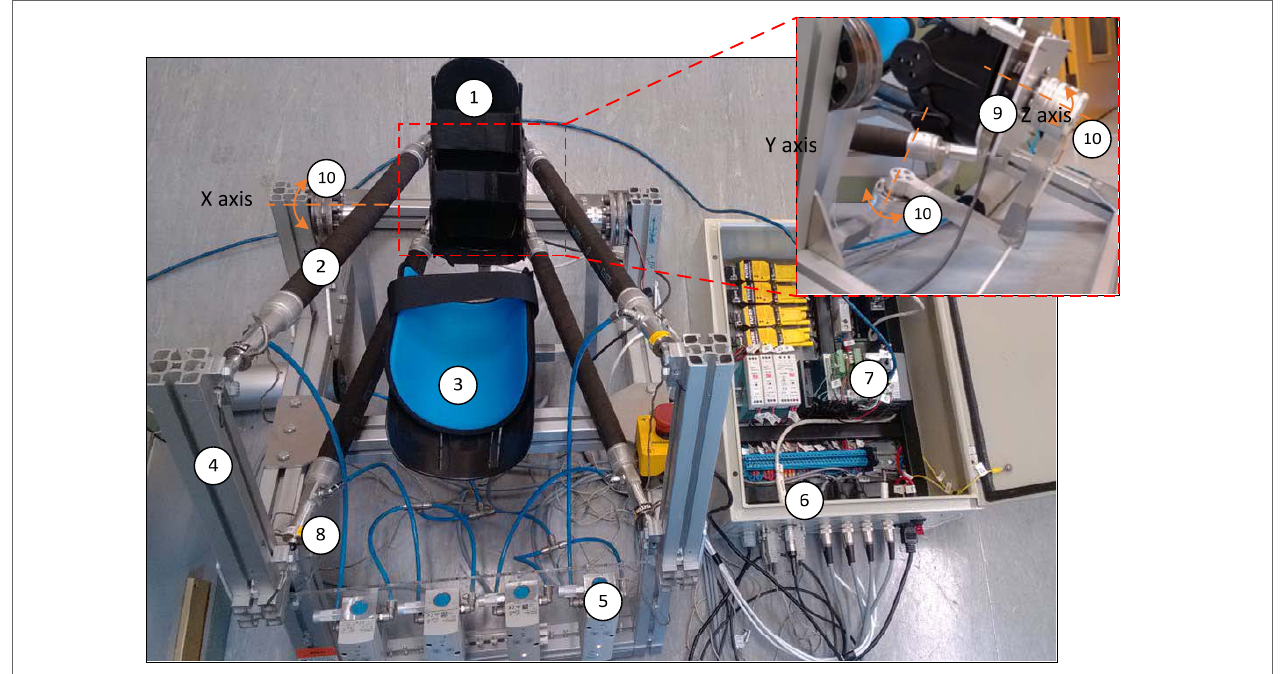
FIGURE 1 | Prototype of the soft ankle rehabilitation robot (ARBOT): (1) end effector, (2) pneumatic muscle actuator (PMAs), (3) leg holder, (4) fixed platform, (5) proportional pressure regulator, (6) control box, (7) embedded controller, (8) single-axis load cell, (9) six-axis force/torque sensor, and (10) rotary encoders.